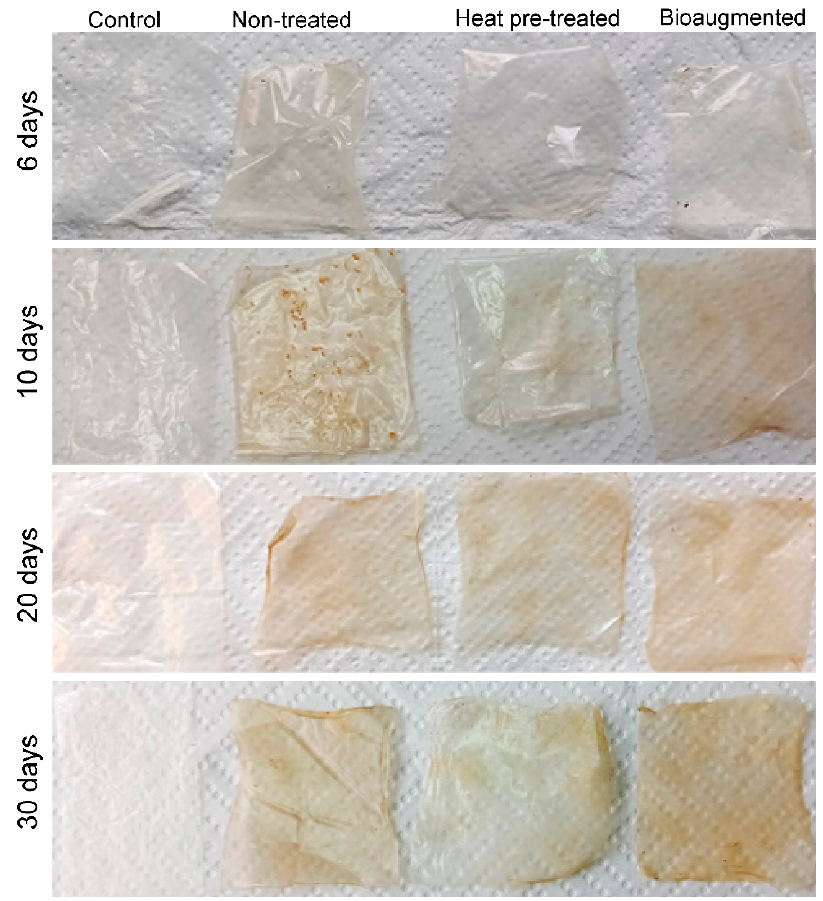
Figure 5. PVA/TPA film samples after compost burial at different time points. Table 4. Weight of washed and dried pieces of plastic bag after compost degradation. The weight of pieces prior to burial was approximately 38 mg.